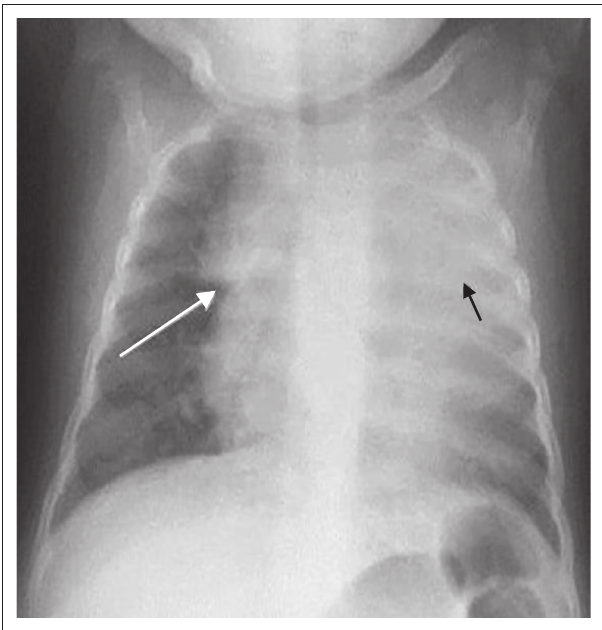
FIGURE 7: The normal thymus may obscure an entire upper lobe, as seen in this radiograph simulating pneumonia (black arrow). Note the notch sign (white arrow) on the right.